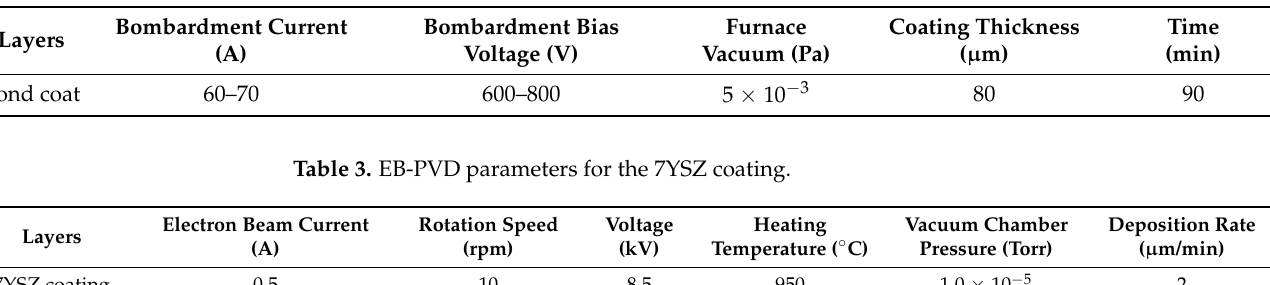
Table 2. AIP deposition parameters for the bond coat.